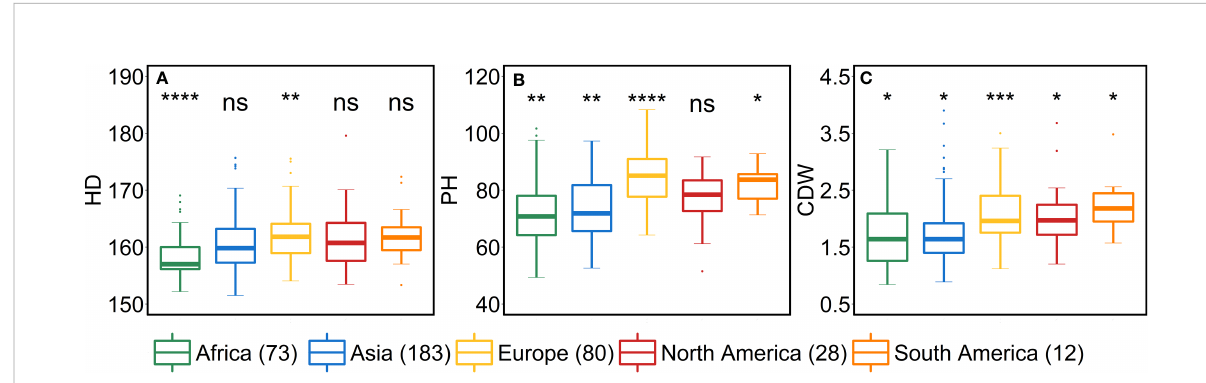
FIGURE 7 Comparison of accessions according to their geographical origin for the shoot traits. (A) heading date (HD in days from January 1 st ), (B) plant height (PH in cm) and (C) culm dry weight (CDW in g). ‘ n ’ denotes the number of accessions in this panel and the number of the accessions belonging to each continent; ****, ***, **, and * = signi fi cance level at the 0.0001, 0.001, 0.01, and 0.05 probability level, respectively and ‘ ns ’ represents insigni fi cant differences and the legend represents different